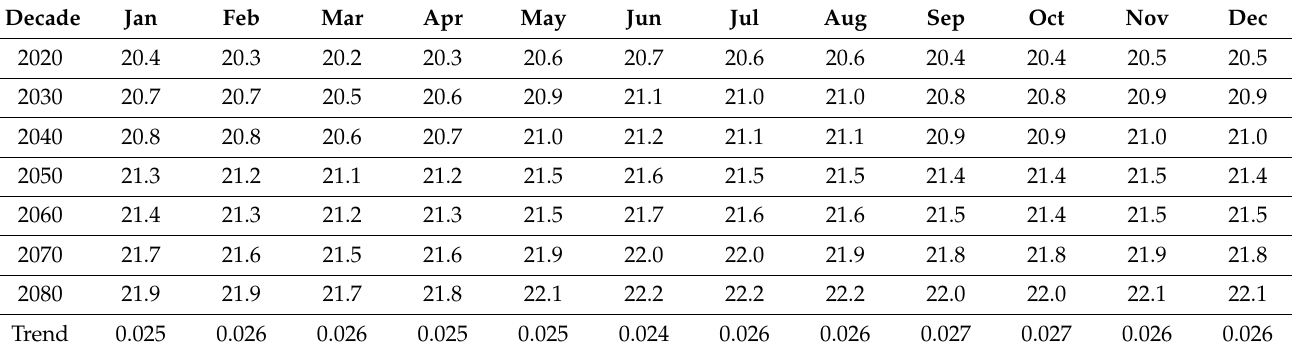
Table 5. Monthly mean temperature values per decade and their trend for Popayan, Colombia, obtained from the application of the delta method to the coupled models (CMIP5) and for the average of the four routes of the Representative Concentration Trajectories (RCP) found in the 2014 IPCC report.